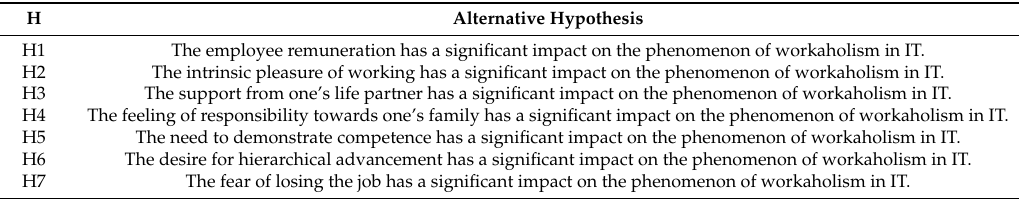
Table 2. The research hypotheses.